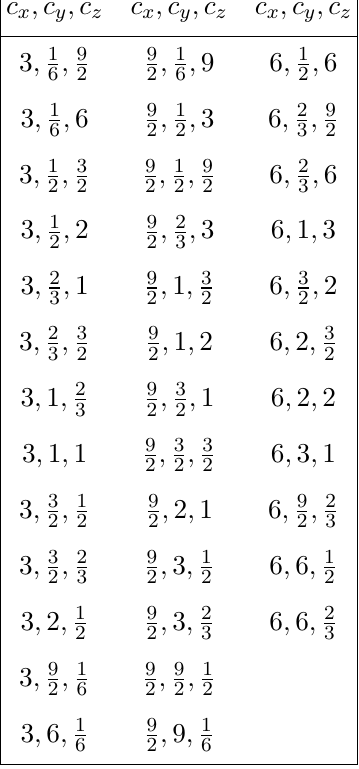
(cid:12) (cid:12) c 2 x (cid:12) (cid:12) (cid:25) in the range between 9 and 14. The possible (cid:12) (cid:12) y s y e c y c z